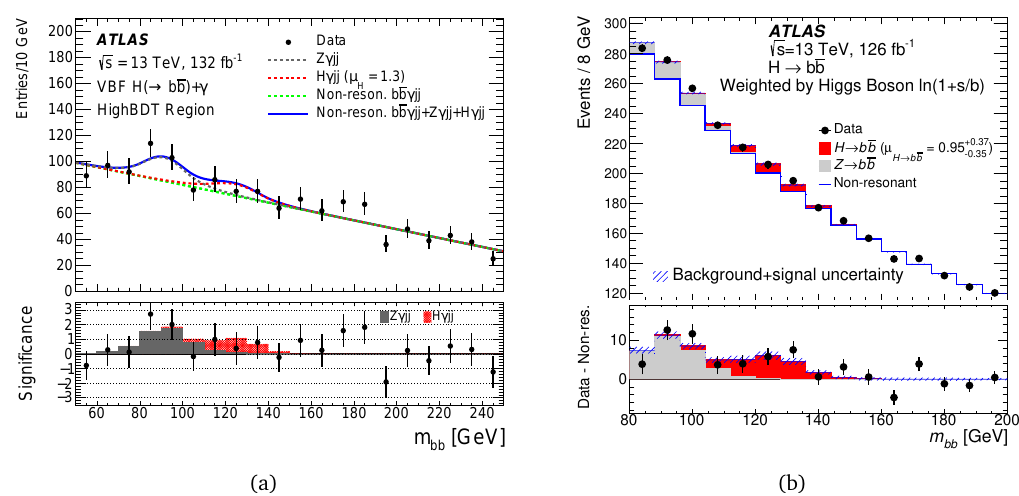
Figure 1: Distributions of the bb invariant mass for two measurements of the H → bb decay with the VBF production: (a) analysis in association with an additional high energy photon [ 12 ] (only the most sensitive signal region is shown), and (b) inclusive VBF H → bb analysis [ 13 ] (events from different analysis categories are weighted depending on their respective signal-to-noise ratio). In both plots, the red (grey) histograms shows contributions from the Higgs boson signals ( Z → bb background). The non-resonant backgrounds are subtracted in the bottom